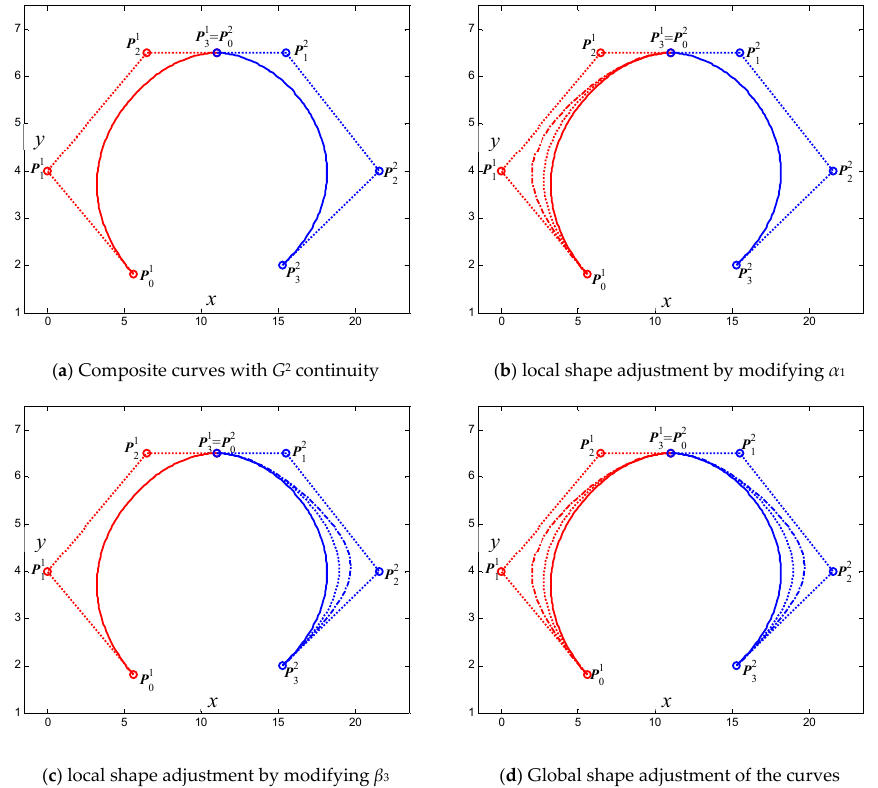
Figure 7. Shape adjustment of the generalized cubic H-Bézier curves with G 2 continuity.